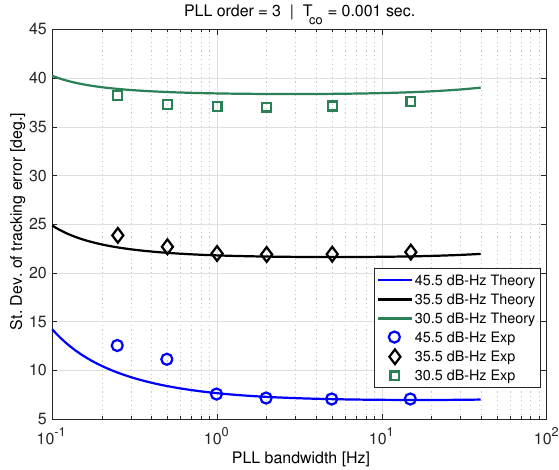
Figure 14. Experimental results with theory using OCXO PSD